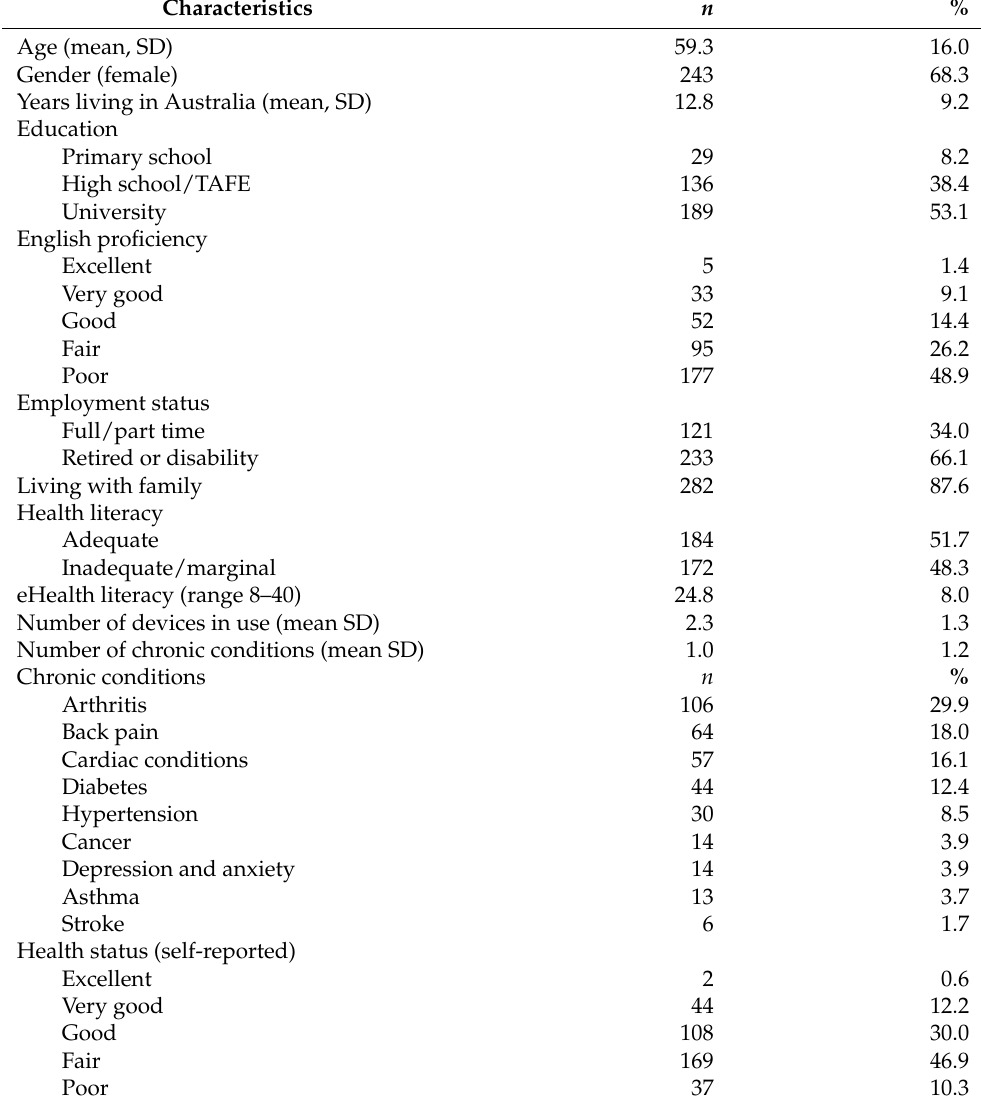
Table 1. Sociodemographic characteristics of the study participants ( n =